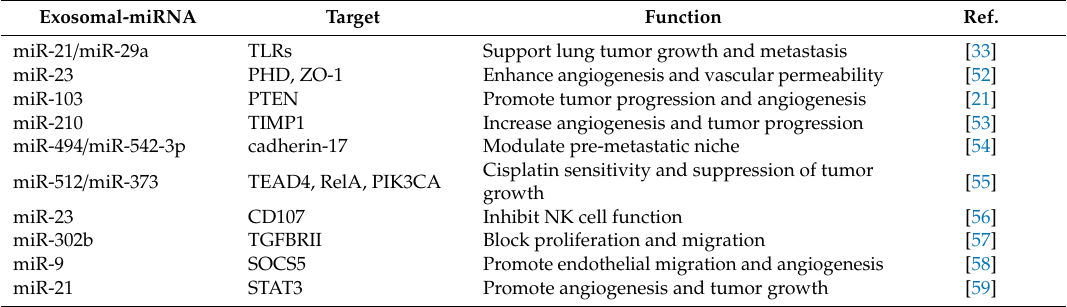
Table 2. Relevant studies on tumor exosomes and their functional role in lung